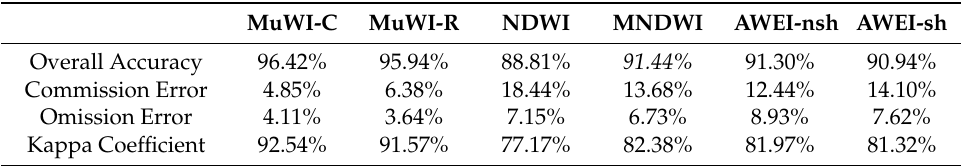
Table 4. Summary of the accuracy of MuWI and four water index methods.